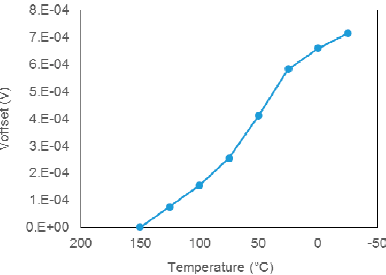
Figure 10. The simulated changes in V off of the 10-bar sensor (with a 350 µm membrane with the diameter of 5 mm) after curing at 150 °C and then cooling down to room temperature.